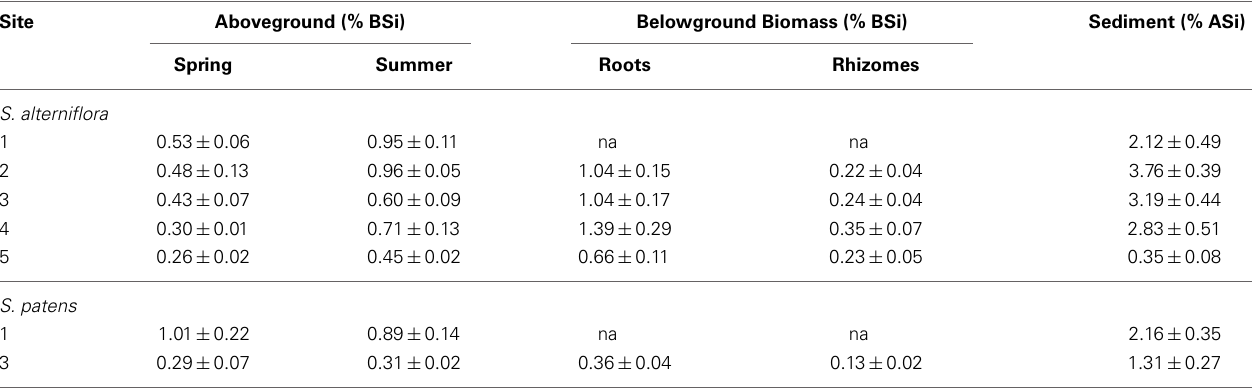
Table 3 | BSi concentrations in aboveground and belowground biomass, and ASi concentrations in sediment at each site. Site